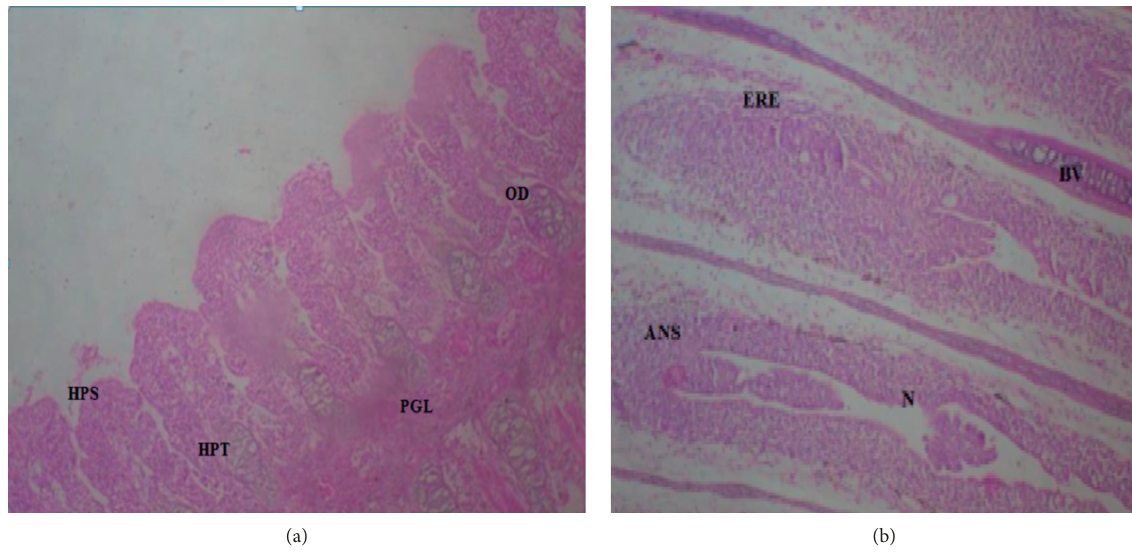
Figure 2: (a) Histological section of gill exposed to bulk SiO. Deformities such as oedema of secondary gill lamella (OD), hypertrophy (HPT), and epithelial hyperplasia are observed (HPS). Primary gill lamella is also observed (H&E stains, × 400). (b) Histological section of gill exposed to bulk CuO. Total destruction of both primary and secondary lamella is seen. Areas of eroded epithelium (ERE), aneurysm (ANS), necrosis (N), and blood vessel (BV) are also observed (H&E stains, ×